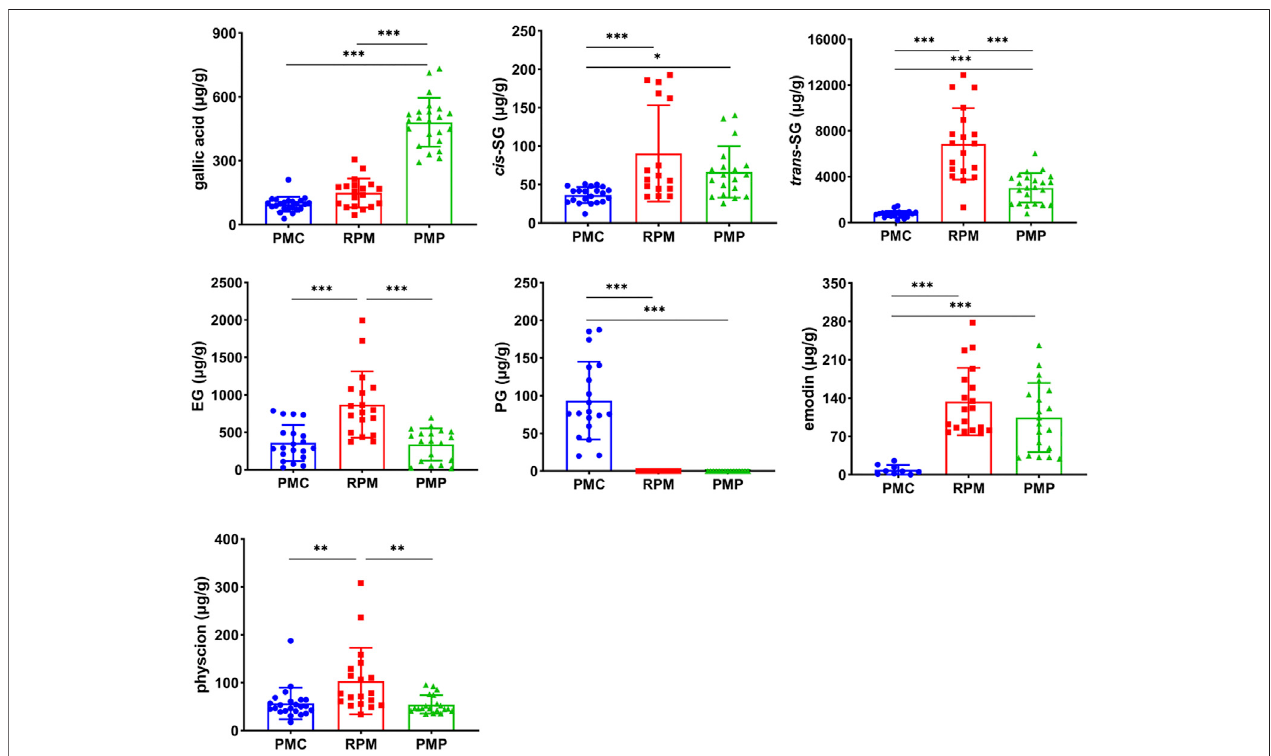
FIGURE3| Contentscomparisonofgallicacid, cis -SG, trans -SG,EG,PG,emodin,andphyscioninPMC,RPM,andPMP.Mean±SD,* p < 0.05,** p < 0.01,*** p < 0.001 by ANOVA.